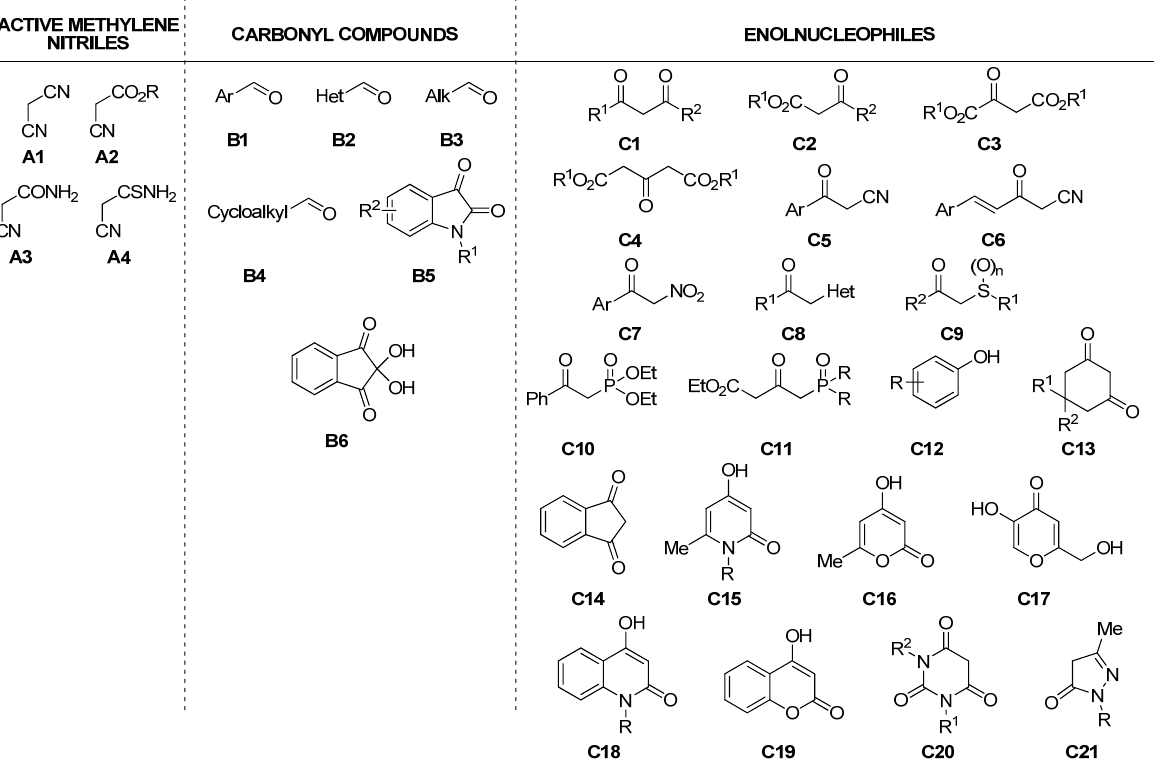
Fig. 2. The variety of components in 2-amino-4 H -pyrans